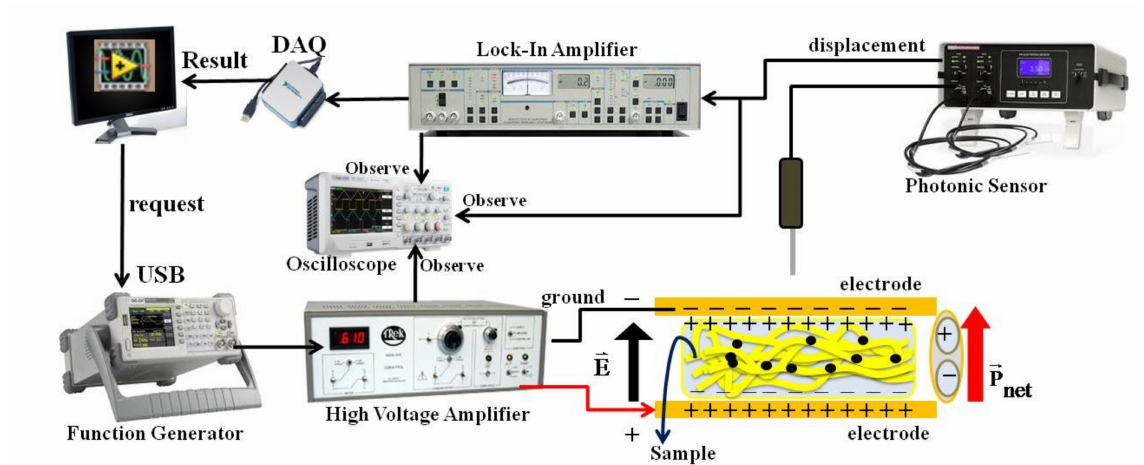
Figure 2. Setup used for measuring the deformation of the sample at low